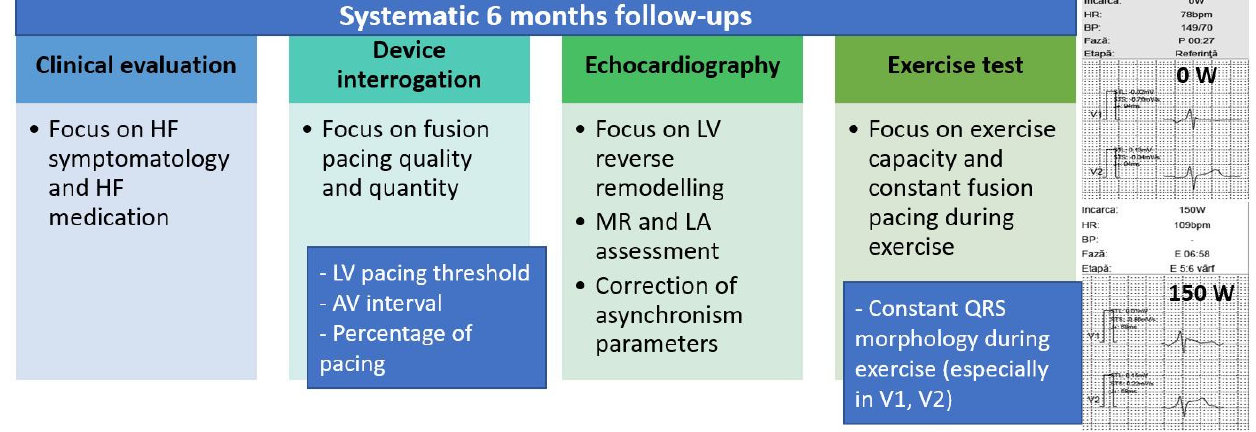
Figure 1. Follow-up evaluation algorithm in patients with fusion pacing CRT.2.3; responder and super-responder parameters.